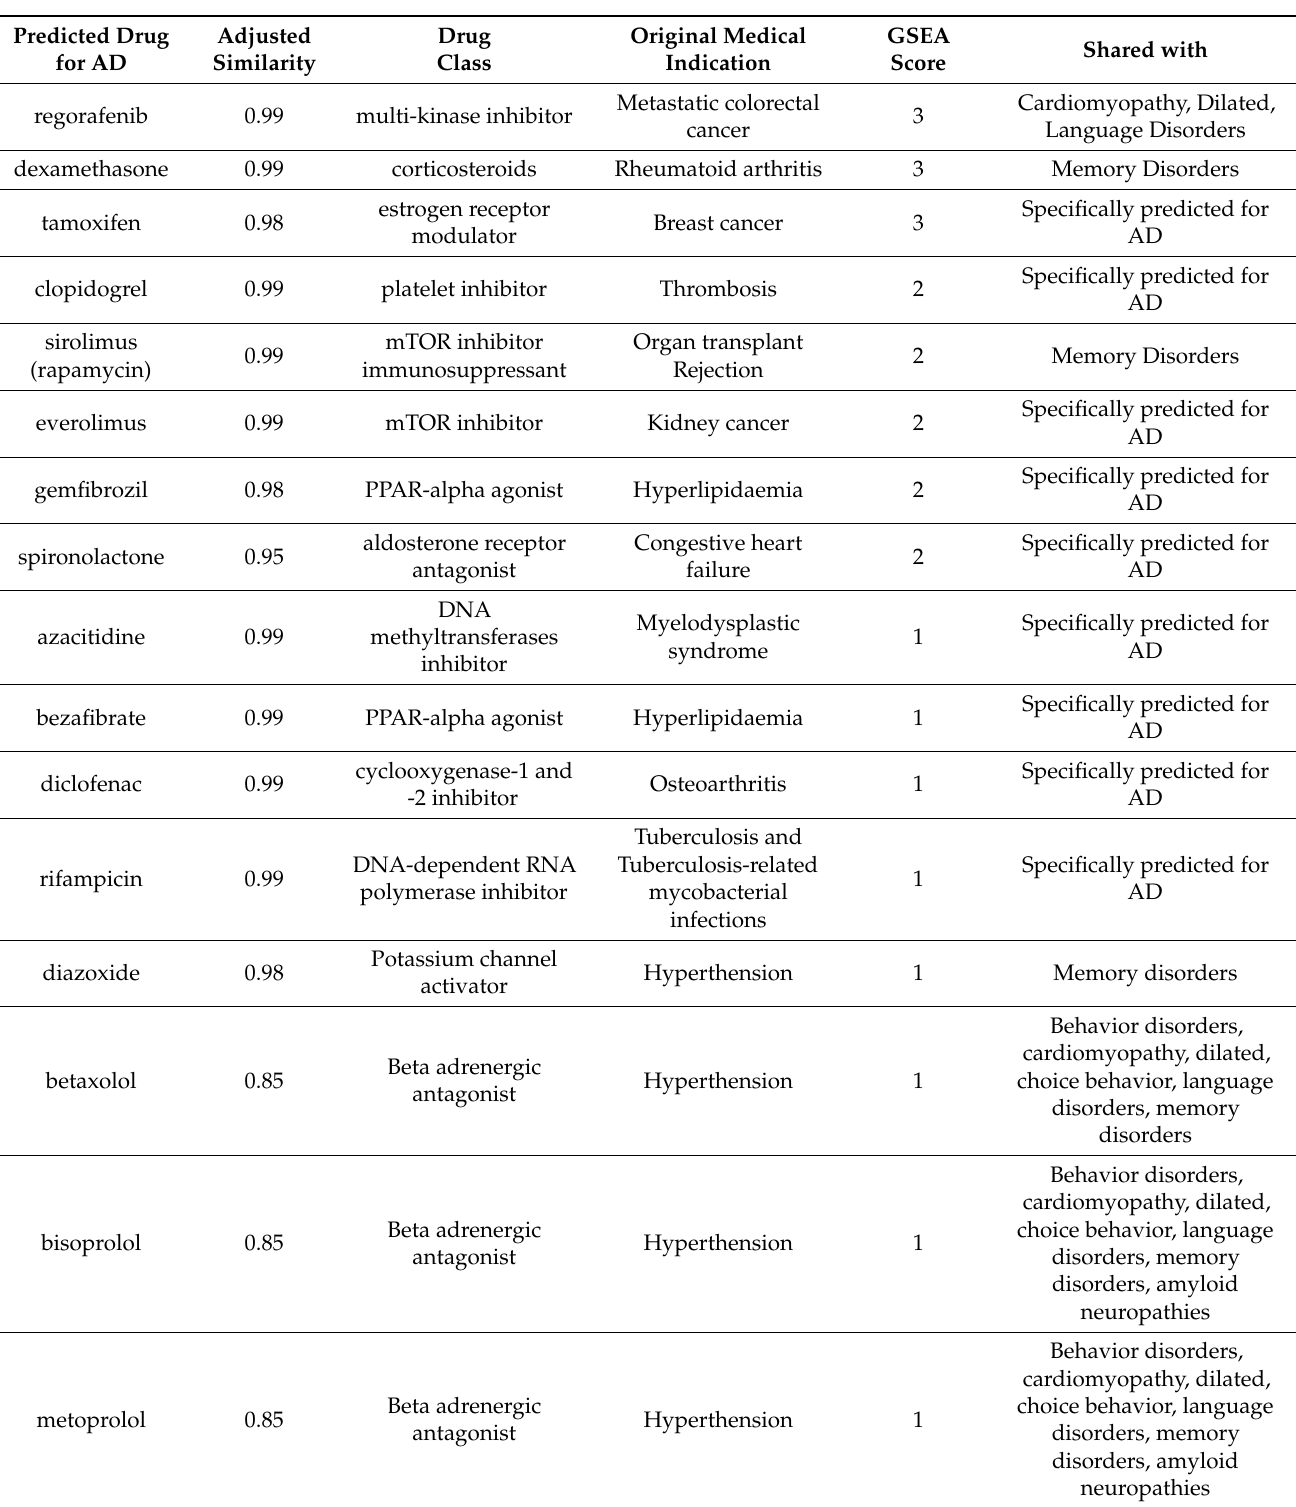
Table 2. Predicted drugs with their adjusted similarity value, GSEA score, and original medical indication from TTD